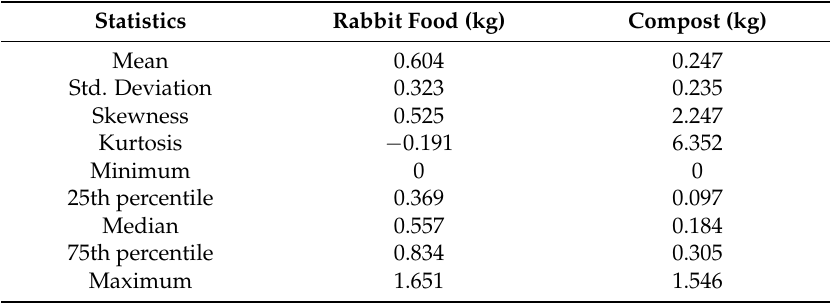
Table 1. Descriptive statistics of the organic material (N = 279).